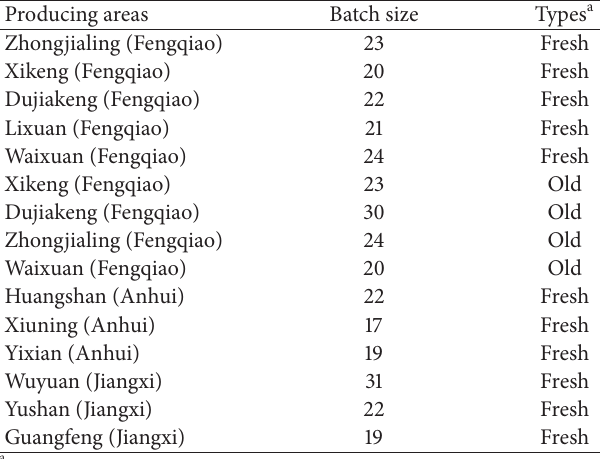
Table 1: Detailed information of the T. grandis seeds analyzed. Producing